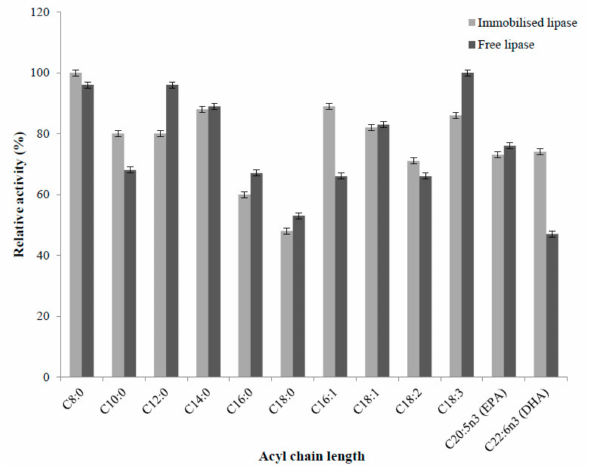
Figure 5. E ff ects of substrate specificity on free and immobilised lipase. The values are given as the mean of three experiments ± standard